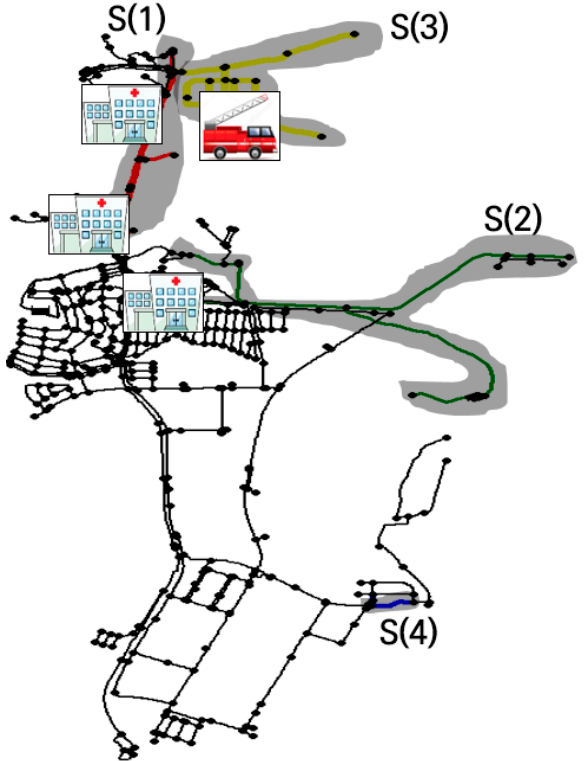
Figure 10. Location of the large-scale segment and important facilities.